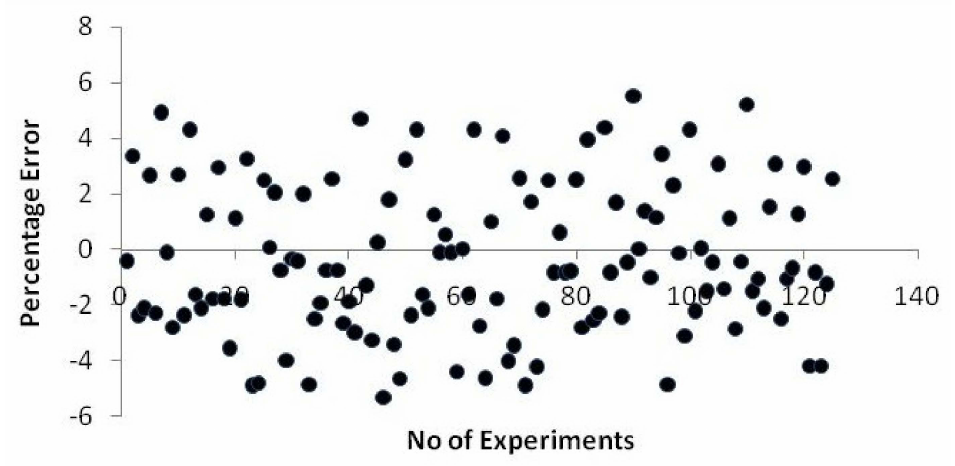
Figure 15. The network 4-4-3 error graph for angular distortion with a time gap between three passes.